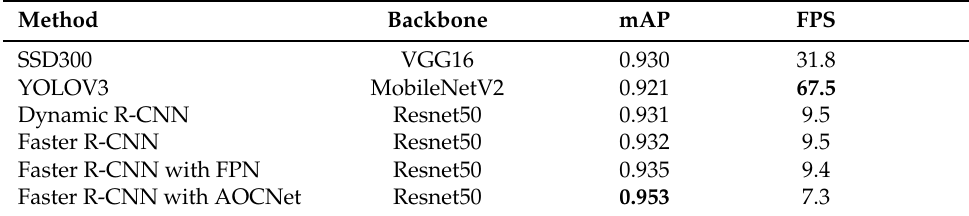
Table 6. The performance of various methods on our